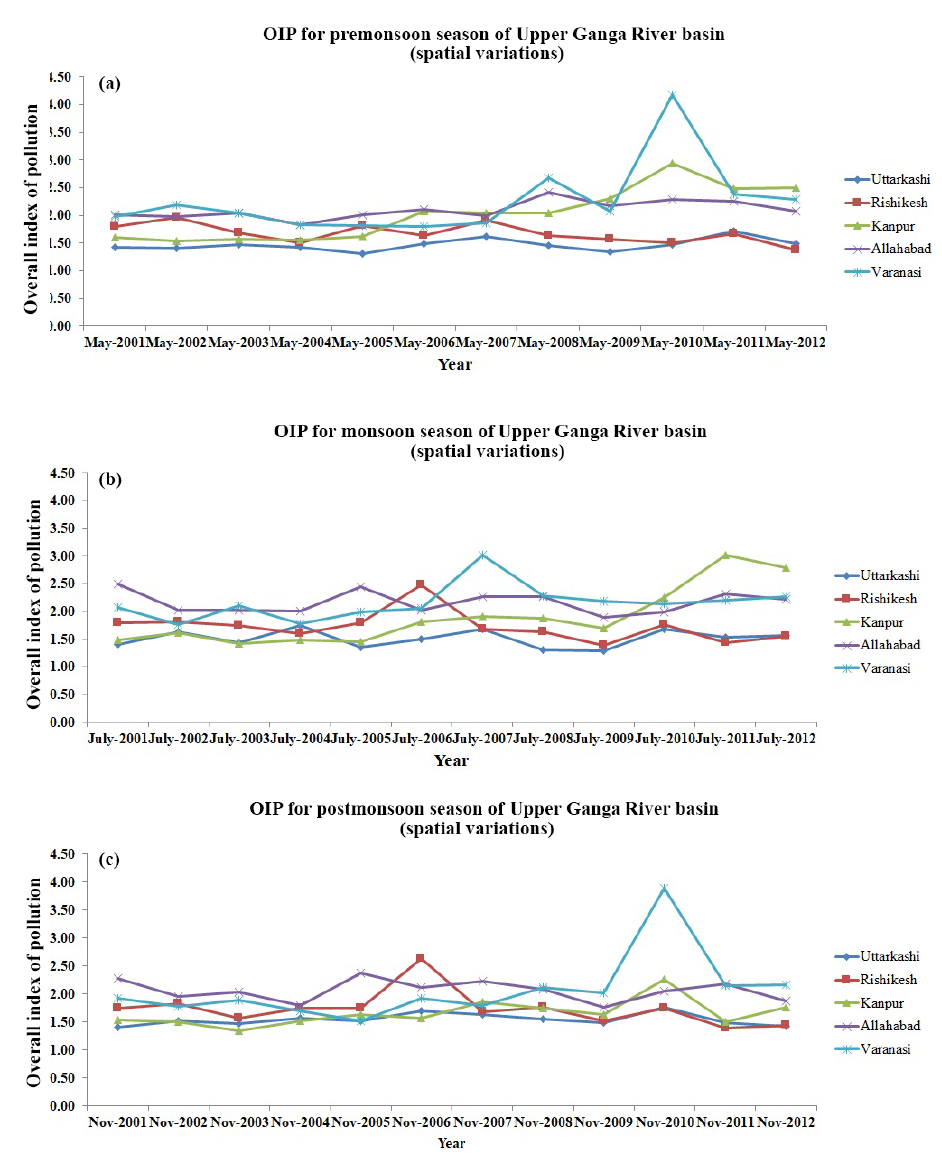
Figure 6. Spatial variations in the overall indices of pollution (OIPs) in the Upper Ganga River basin from 2001 to 2012 for the (a) premon- soon period (b) monsoon period, (c) postmonsoon